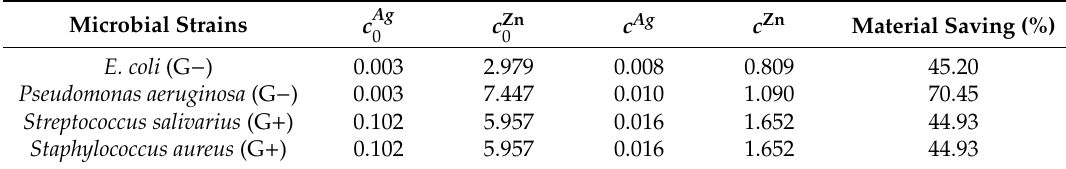
Figure 7. Scheme of the synergistic effect calculation. Was the needed amount of the two separated antimicrobial agents the same as when they acted together? Table 4. Calculated partial MIC (mg·cm − 3 ) as described in the text and the corresponding synergistic effect in a form of material savings. The Candida albicans is not listed, because Zn was inactive in the measured range and the corresponding synergistic effect could not be calculated.